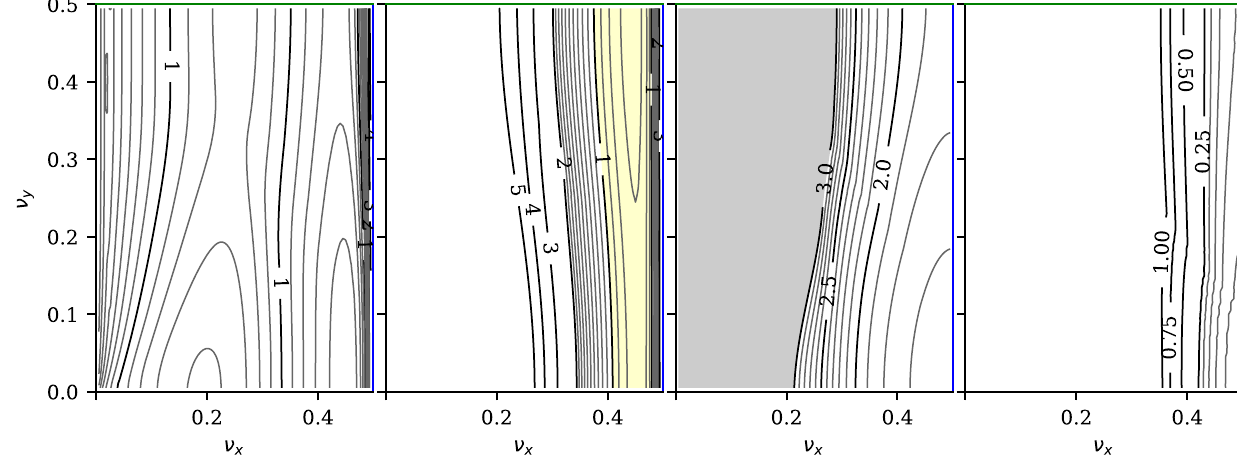
FIG. 12. Figures of merit for G -optimized solutions with extended sextupole harmonics ( P ¼ 2 ) in tune space. See legend in Fig.